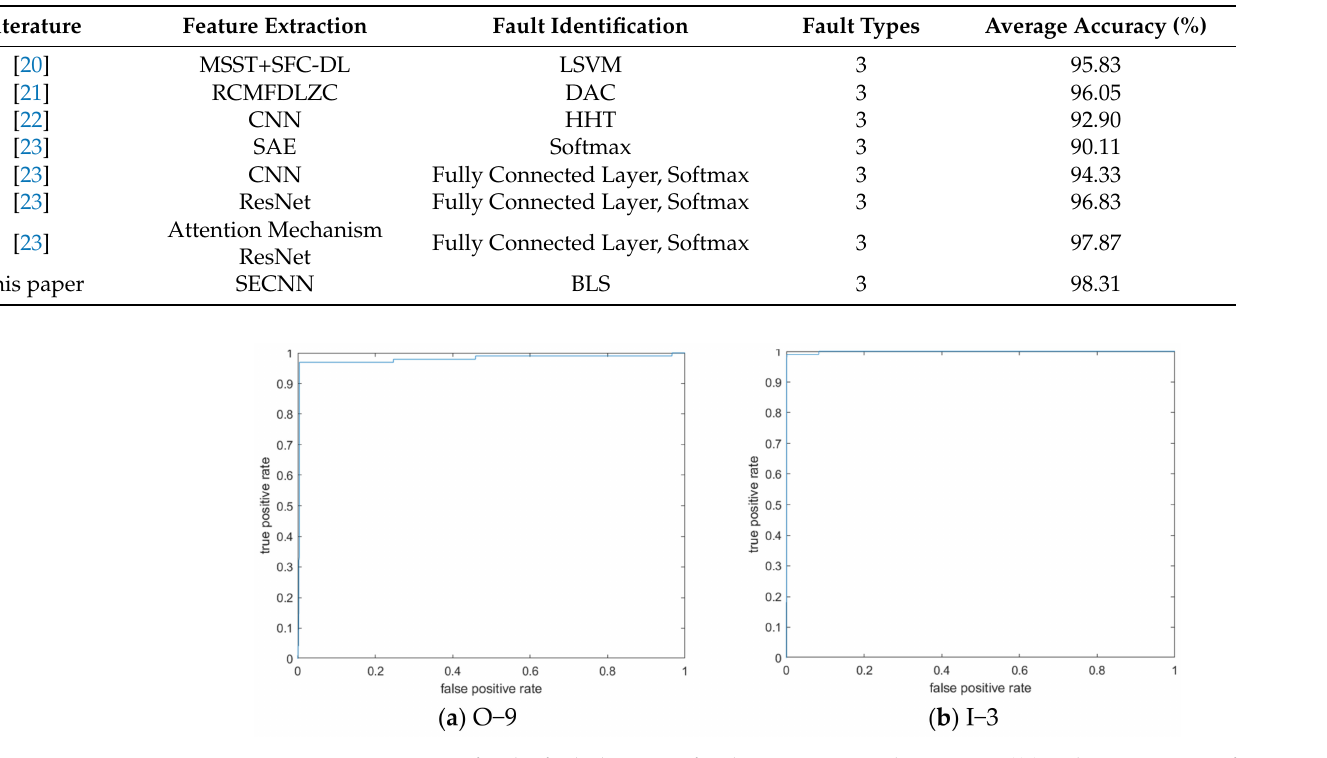
Figure 7. ROC curves for the fault diagnosis for the inner ring and outer ring (( a ) is the ROC curve of label O-9, and ( b ) is the ROC curve of label